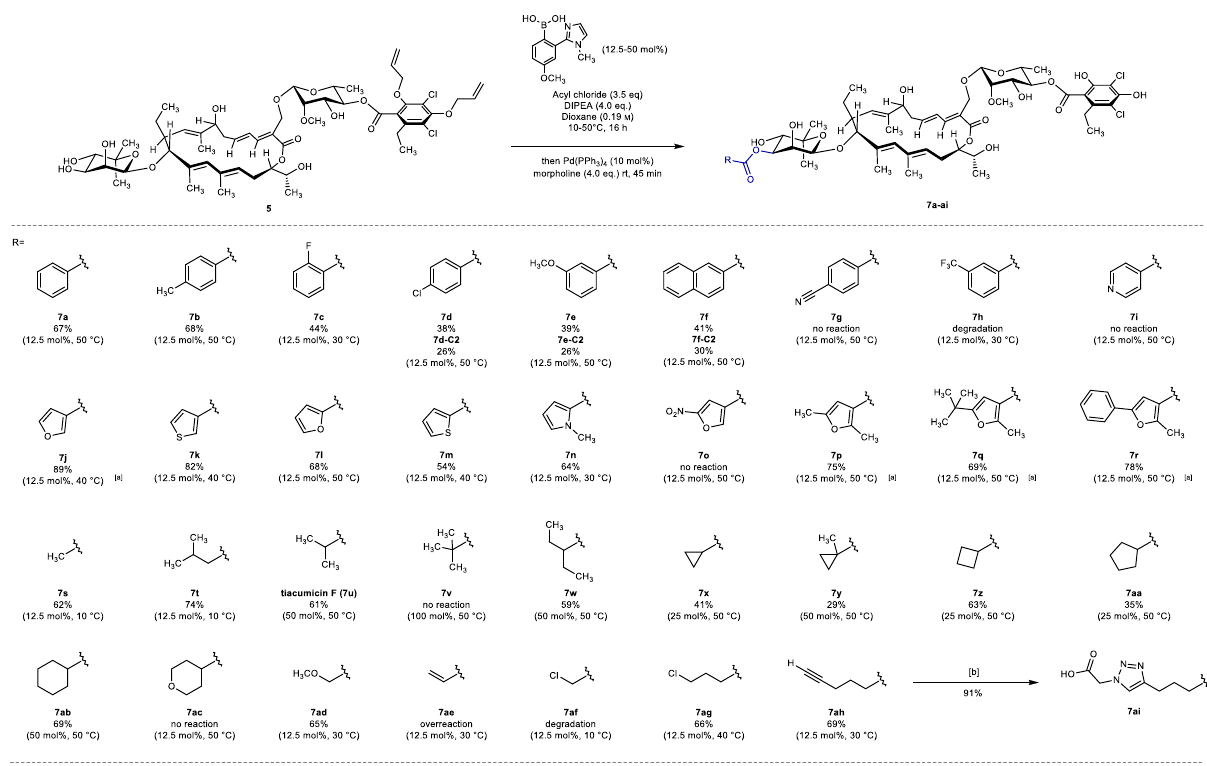
Fig. 7 Scope of selective C3 ” -functionalization of 5. Acylation of 5 applying the optimized catalyst system with various acyl chlorides.